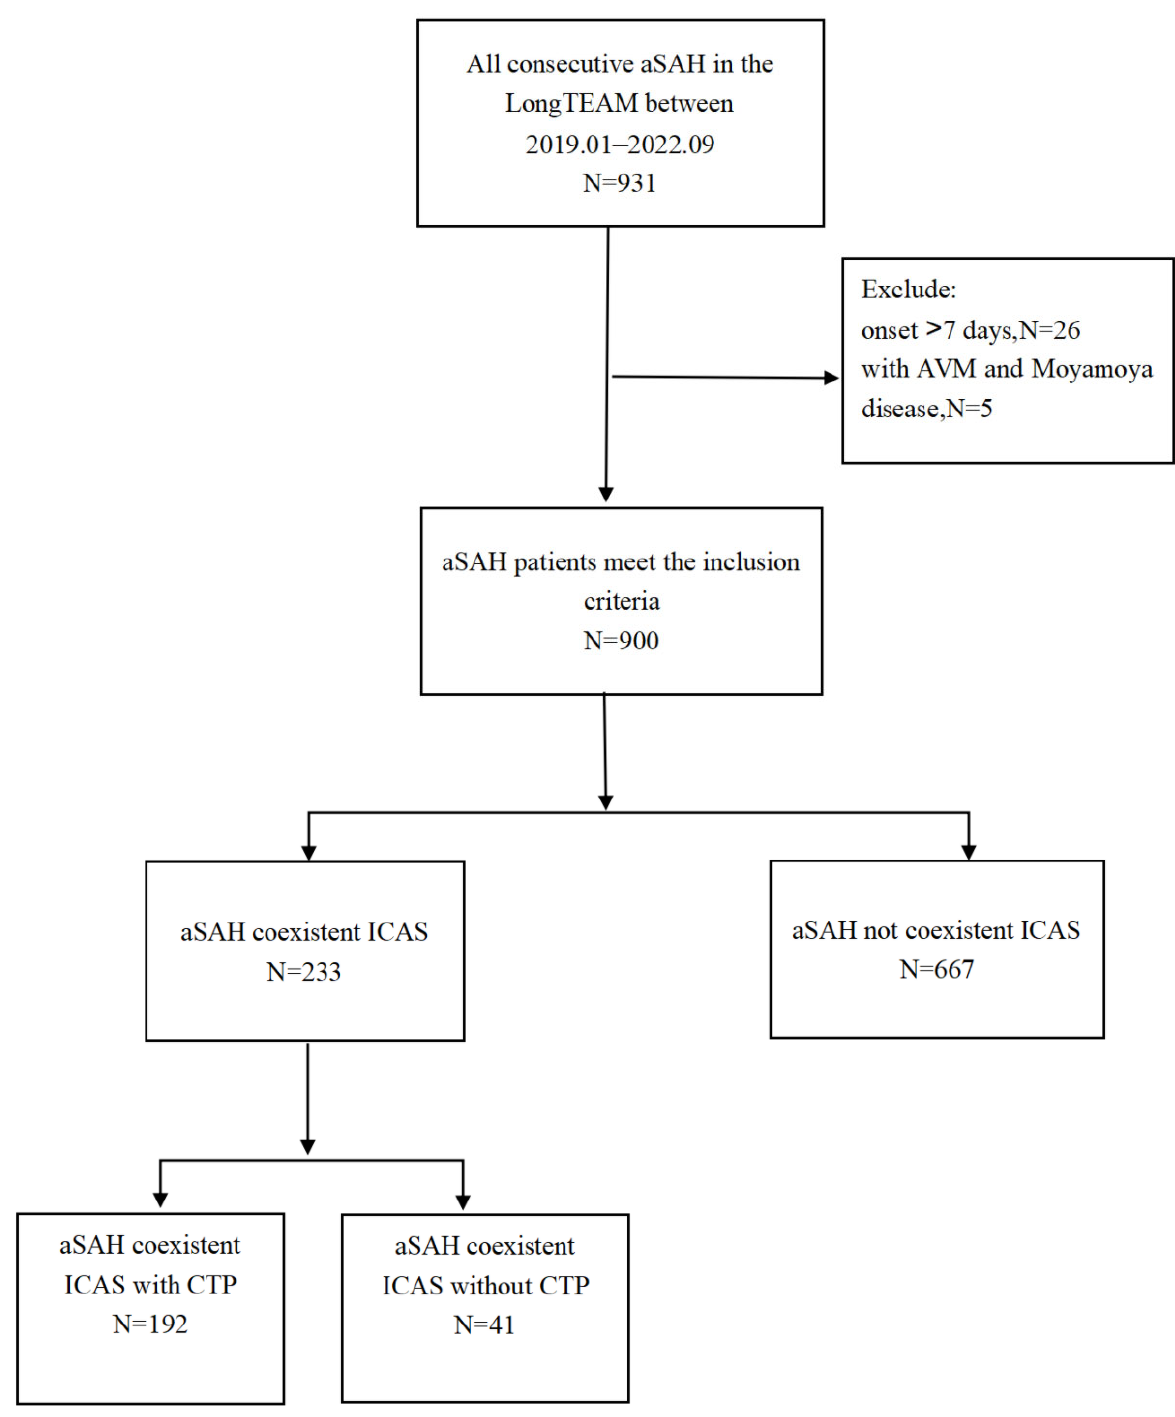
Figure 1. Flow diagram of the enrolled patients. Table 1. Baseline characteristics of patients with coexistent aSAH and ICAS.